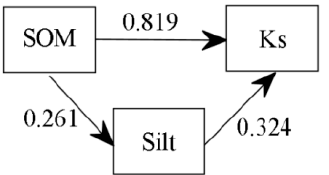
Figure 6. Distribution of K S along the soil profile ( a ) and the differences in average K S in the different forests ( b ) in Dinghushan. Values are the means ± SE. Lowercase letters above the columns represent statistically significant differences among stand types (Duncan’s test, p < 0.05). Abbreviations: K S , saturated hydraulic conductivity; PF, Pinus massoniana forest; MF, mixed Pinus massoniana /broad- leaved forest; BF, monsoon evergreen broad-leaved forest.